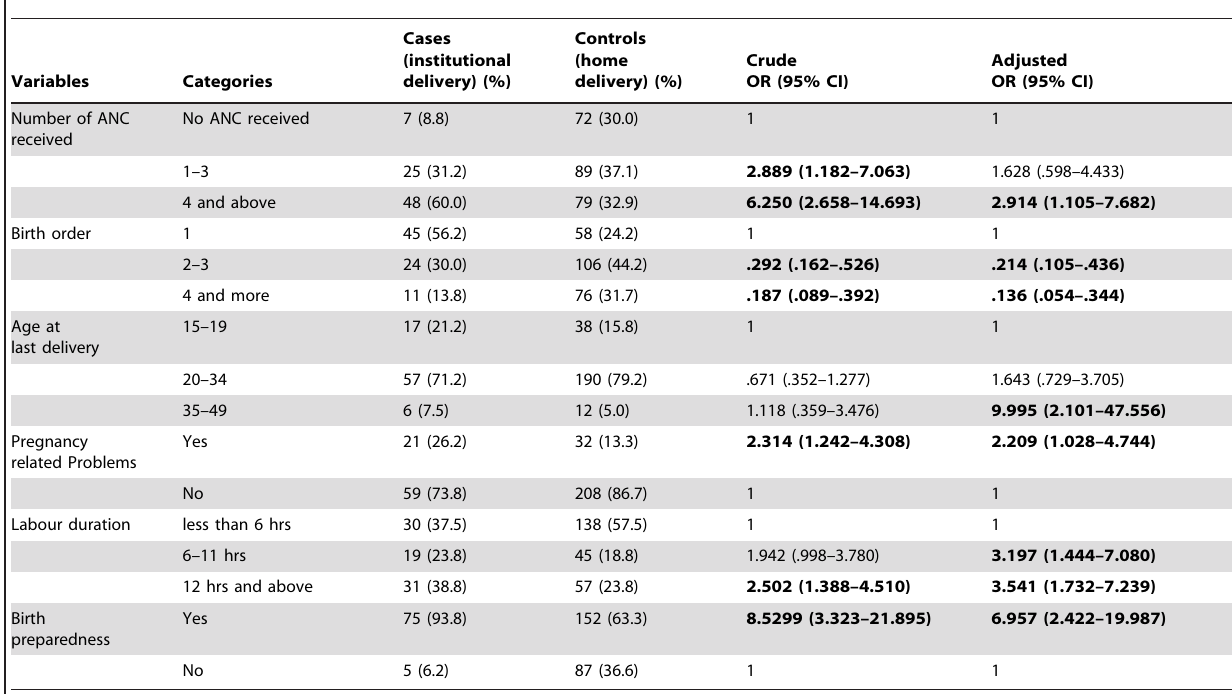
Table 3. Antenatal care and reproduction related determinants of institutional delivery in Western Ethiopia, October 2013.